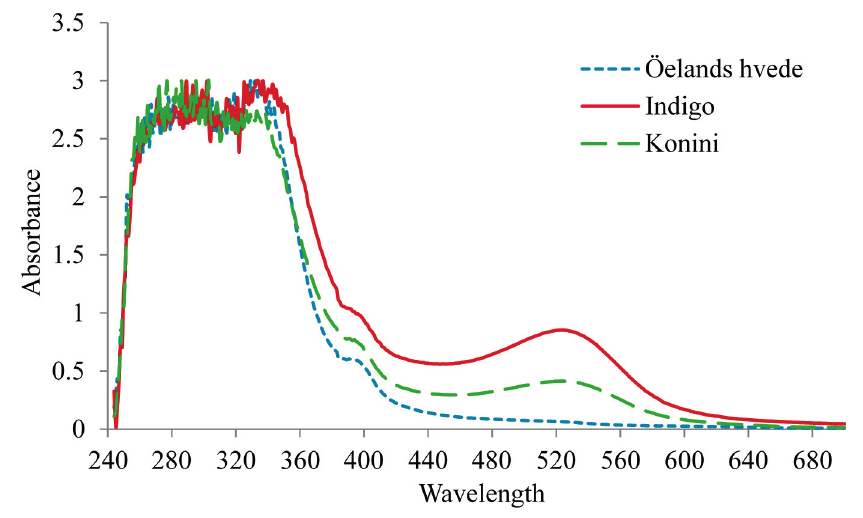
Figure 4. UV/Visible spectra of raw wheat flour at different